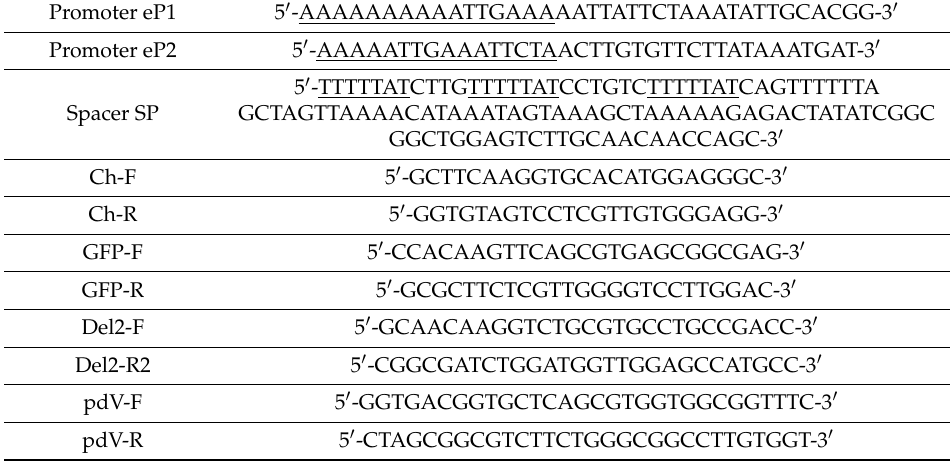
Table 1. Primer and promoter sequences. The critical core sequences of the synthetic early promoter eP1 and eP2, respectively, are given; the 3 consecutive early stop motifs T5NT in the Spacer region are underlined. The 16 nt core of early promoters is double underlined, the early stop motif T5NT is underlined. Sequences of the PCR primers used are